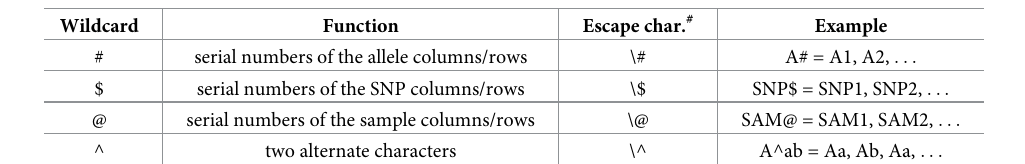
Table 2. Wildcards and escape characters.